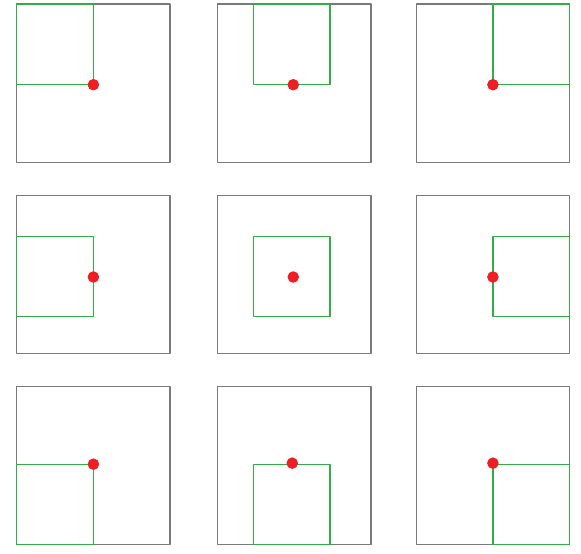
Figure 2: Example of extracting